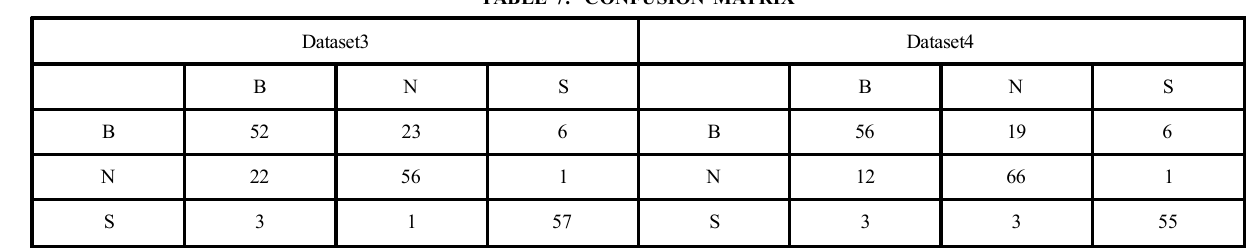
TABLE 7. CONFUSION